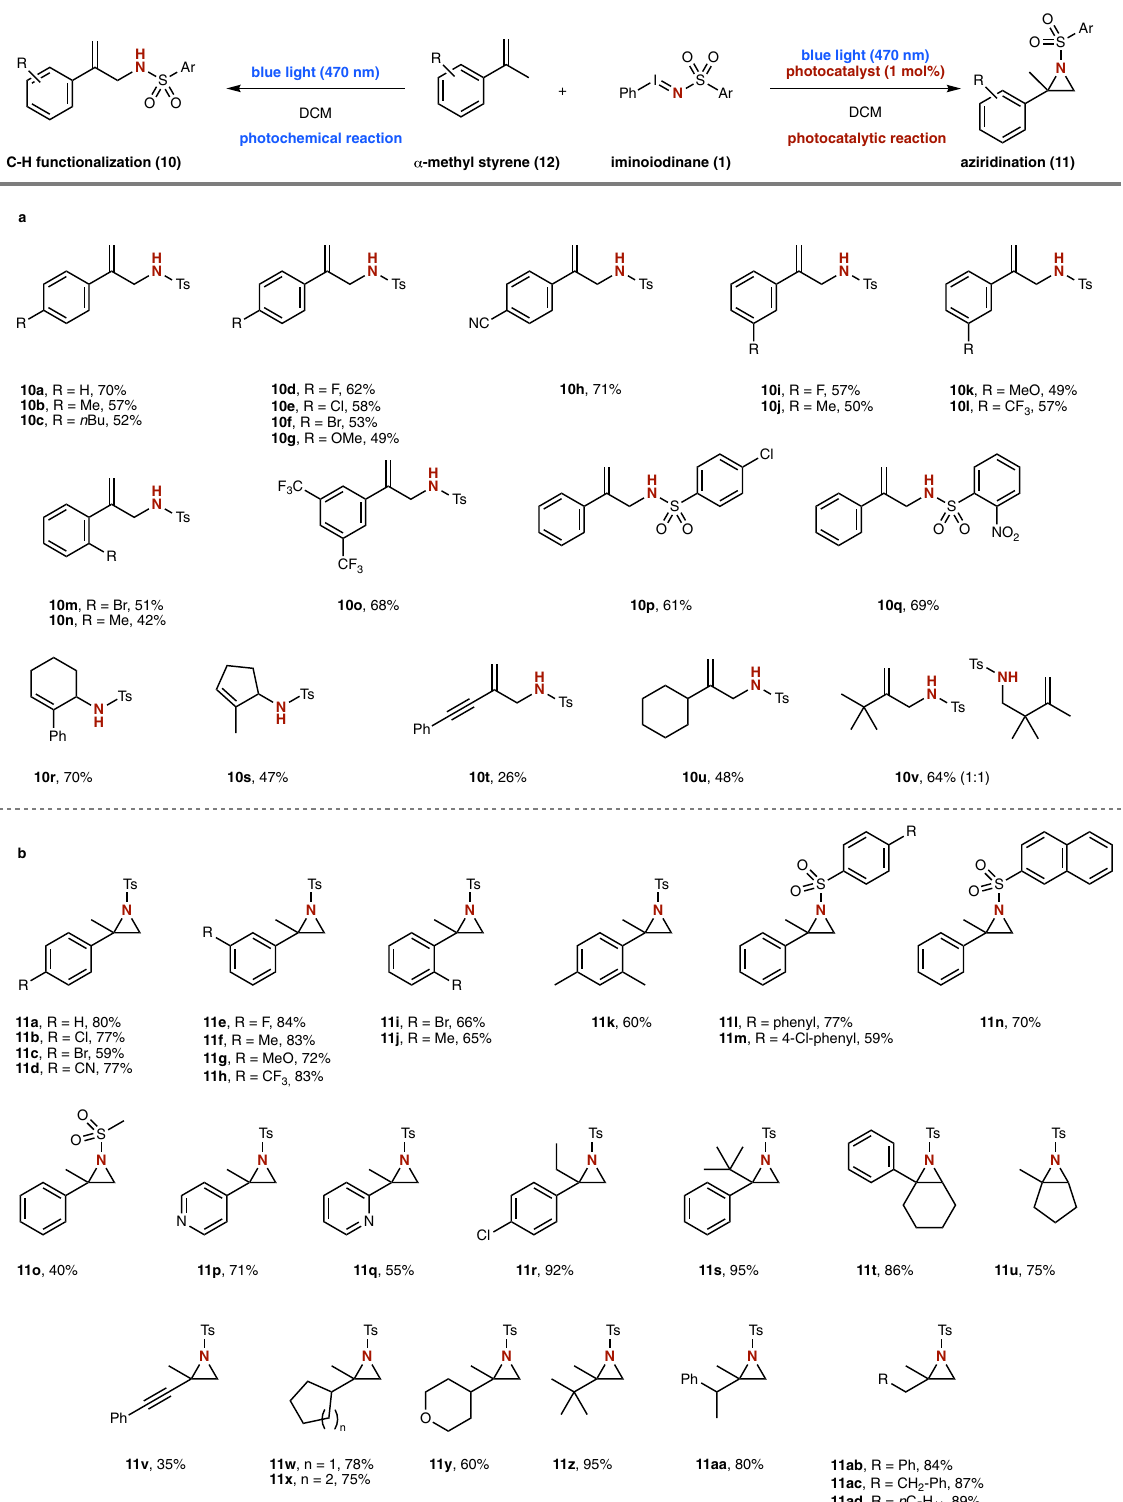
Fig. 5 Scope of the nitrene transfer reactions in the photochemical C-H functionalization and photocatalytic aziridination reaction via nitrene radical anions. a Photochemical reaction with α -methyl styrenes. b Photocatalytic reaction with α -methyl styrenes.